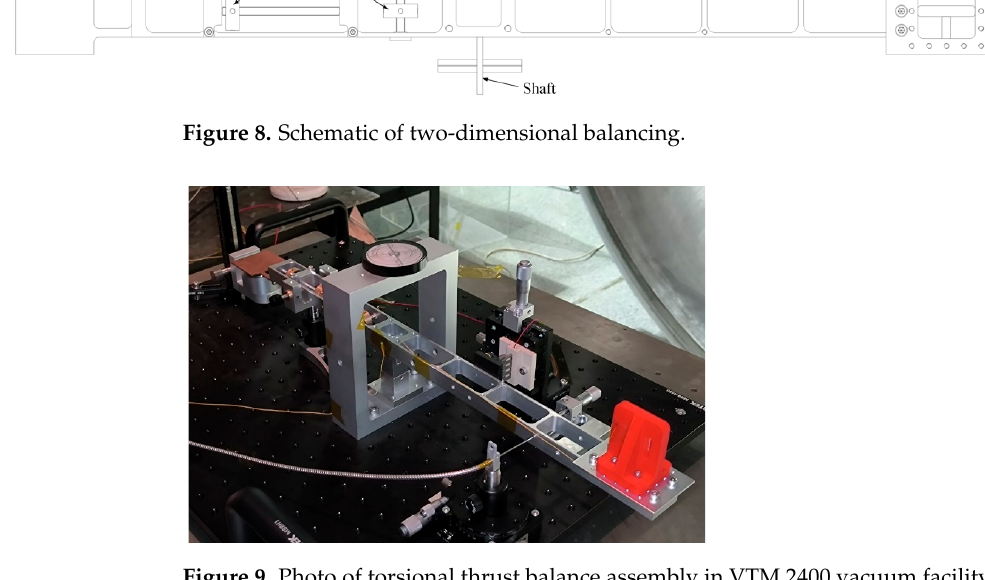
Figure 9. Photo of torsional thrust balance assembly in VTM 2400 vacuum facility.